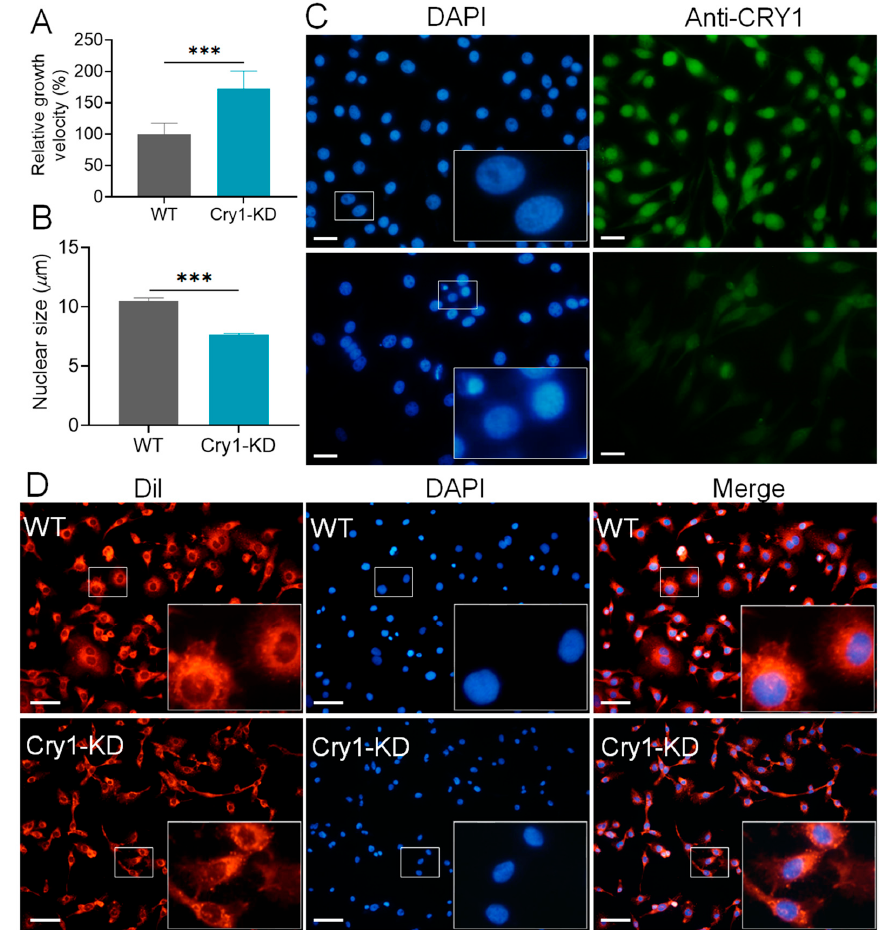
Figure 2. Effect of knockdown BmCry1 on cell growth. ( A ) Cell growth velocity was measured using the MTT method ( n = 3). ( B ) Cell nuclei diameters differ between Cry1-KD cells and WT cells. When the cell fusion degree in cell vials reached 70%, cells were seeded on coverslips. DAPI staining was performed on the cells after adherence (at least 12 h) and the diameters of the nuclei were measured. cell nuclei diameters were quantified by analyzing cells in five randomly selected fields on a coverslip ( n = 3). ( C ) BmCRY1 protein content in BmN and Cry1-KD cells was investigated by immunofluorescence. bar = 50 μ m. ( D ) Cell nuclei stained with DAPI and cell membranes stained with Dil. bar = 50 μ m. WT, wild-type cells; Cry1-KD, BmCry1 knockdown cells. ***, p ≤ 0.001.